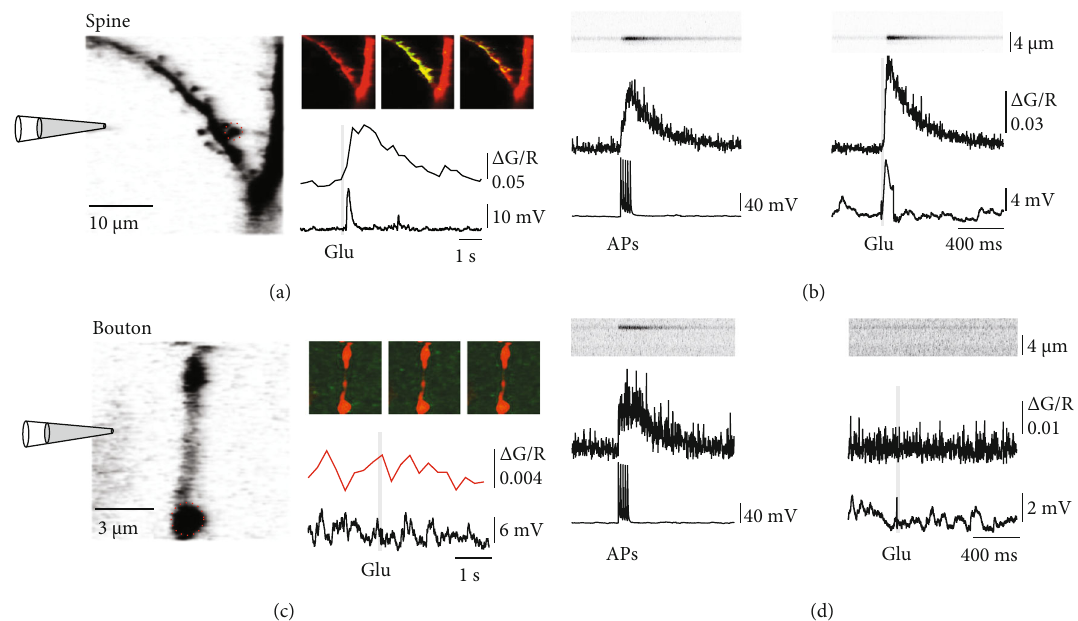
Figure 3: Iontophoresis of glutamate does not evoke Ca 2+ signals in boutons. (a) Two-photon fl uorescence image of a dendrite of a spiny stellate neuron loaded with the Ca 2+ indicator OGB-1 (200 μ M) and the morphological dye Alexa 594 (50 μ M). The position of the iontophoresis pipette for glutamate application is indicated. To the right, three fl uorescence images taken before, 1s after and 5s after glutamate application, are shown. Below, the time-course of the fl uorescence change in the region of interest indicated by the red, dashed circle (upper trace) and the somatic membrane potential (lower trace) are presented. Grey bar represents time of glutamate application. (b) Left, line-scan through a spine of another cell and the corresponding Ca 2+ transient evoked by a burst of 5 APs at 50Hz. Right, line- scan through the same spine during iontophoresis of glutamate. A clear increase in Ca 2+ can be seen upon iontophoresis. (c) Two- photon fl uorescence image of an axon of a spiny stellate neuron located in L2/3 loaded with the Ca 2+ indicator OGB-1 (200 μ M) and the morphological dye Alexa 594 (50 μ M). The position of the iontophoresis pipette for glutamate application is indicated. To the right, three fl uorescence images taken before, 1s after and 3 s after glutamate application, are shown. Below, the time-course of the fl uorescence change in the region of interest indicated by the red, dashed circle (upper trace) and the somatic membrane potential (lower trace) is presented. Grey bar represents time of glutamate application. No increase in Ca 2+ is apparent upon iontophoresis of glutamate onto the axon. (d) Left, line-scan through a bouton of another cell and the corresponding Ca 2+ transient evoked by a burst of 5 APs at 50Hz. Right, line-scan through the same bouton during iontophoresis of glutamate. An increase in Ca 2+ is evoked by the APs, but not by iontophoresis of glutamate.